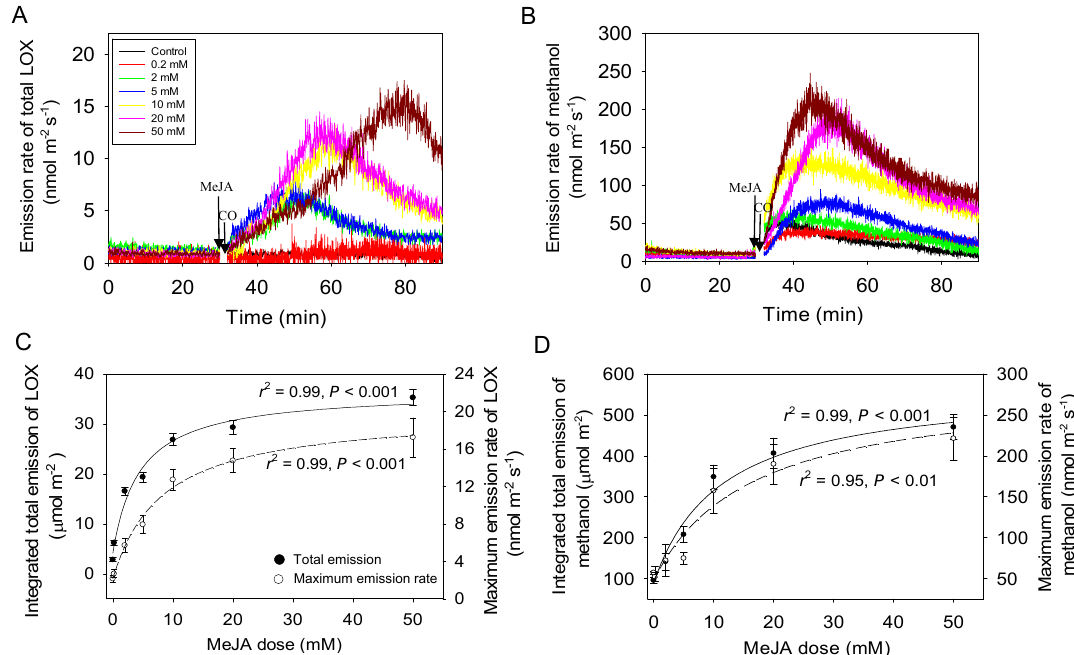
Figure 2. Sample responses of lipoxygenase pathway (LOX) compound ( A ) and methanol ( B ) emissions before (0–30 min) and after (30–90 min) MeJA application and corresponding average ± SE ( n = 3) total emission and maximum emission rates of LOX compounds ( C ) and methanol ( D ) in Cucumis sativus leaves. The applied MeJA concentrations as in Figure 1. The hyperbolic regressions describing the statistical e ff ects of MeJA on LOX ( C ) were: y = 5.89 + 31.5 x / (5.44 + x ), r 2 = 0.99, p < 0.001 (total); y = 2.15 + 17.8 x / (8.34 + x ), r 2 = 0.99, p < 0.001 (maximum). The corresponding regressions for methanol ( D ) were: y = 89.8 + 481 x / (11.4 + x ), r 2 = 0.99, p < 0.001 (total); y = 47.91 + 239 x / (16.2 + x ), r 2 = 0.95, p < 0.01 (maximum). The emission of methanol was calculated from the protonated parent ion with mass / charge ( m / z ) ratio of 33 + [ m 33 , methanol]. Total emission of volatiles produced within the octadecanoid